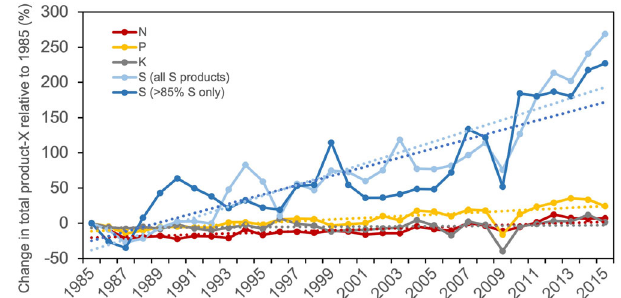
Fig. 3 Percent change in N, P, K, and S products relative to 1985. The total load of each element was calculated based on the stoichiometry of the fertiliser products and the mass of each product sold. Best fi t lines are slope = 0.7% change in N yr − 1 , R 2 = 0.52; slope = 1.2% change in P yr − 1 , R 2 = 0.62; slope = 0.1% change in K yr − 1 , R 2 = 0.01; slope = 7.7% change in all S products yr − 1 , R 2 = 0.82; and slope = 6.6% change in sulfur-S yr − 1 , R 2 = 0.71. For the period from 2009 – 2015, the slopes of the trendlines for all S-containing products and sulfur-S are 29.6% yr − 1 ( R 2 = 0.91 and p < 0.006) and 21.1% yr − 1 ( R 2 = 0.55 and p < 0.04), respectively. All linear models are statistically signi fi cant ( p < 0.001) except K ( p = 0.52). The slopes of N, P, and K trends are signi fi cantly different from those of all S-containing and sulfur-S products ( p < 0.0001); the trend in sulfur-S is not signi fi cantly different from that of all S containing products ( p = 0.093). Only the slopes of all S products and sulfur-S are signi fi cantly different from zero ( p <